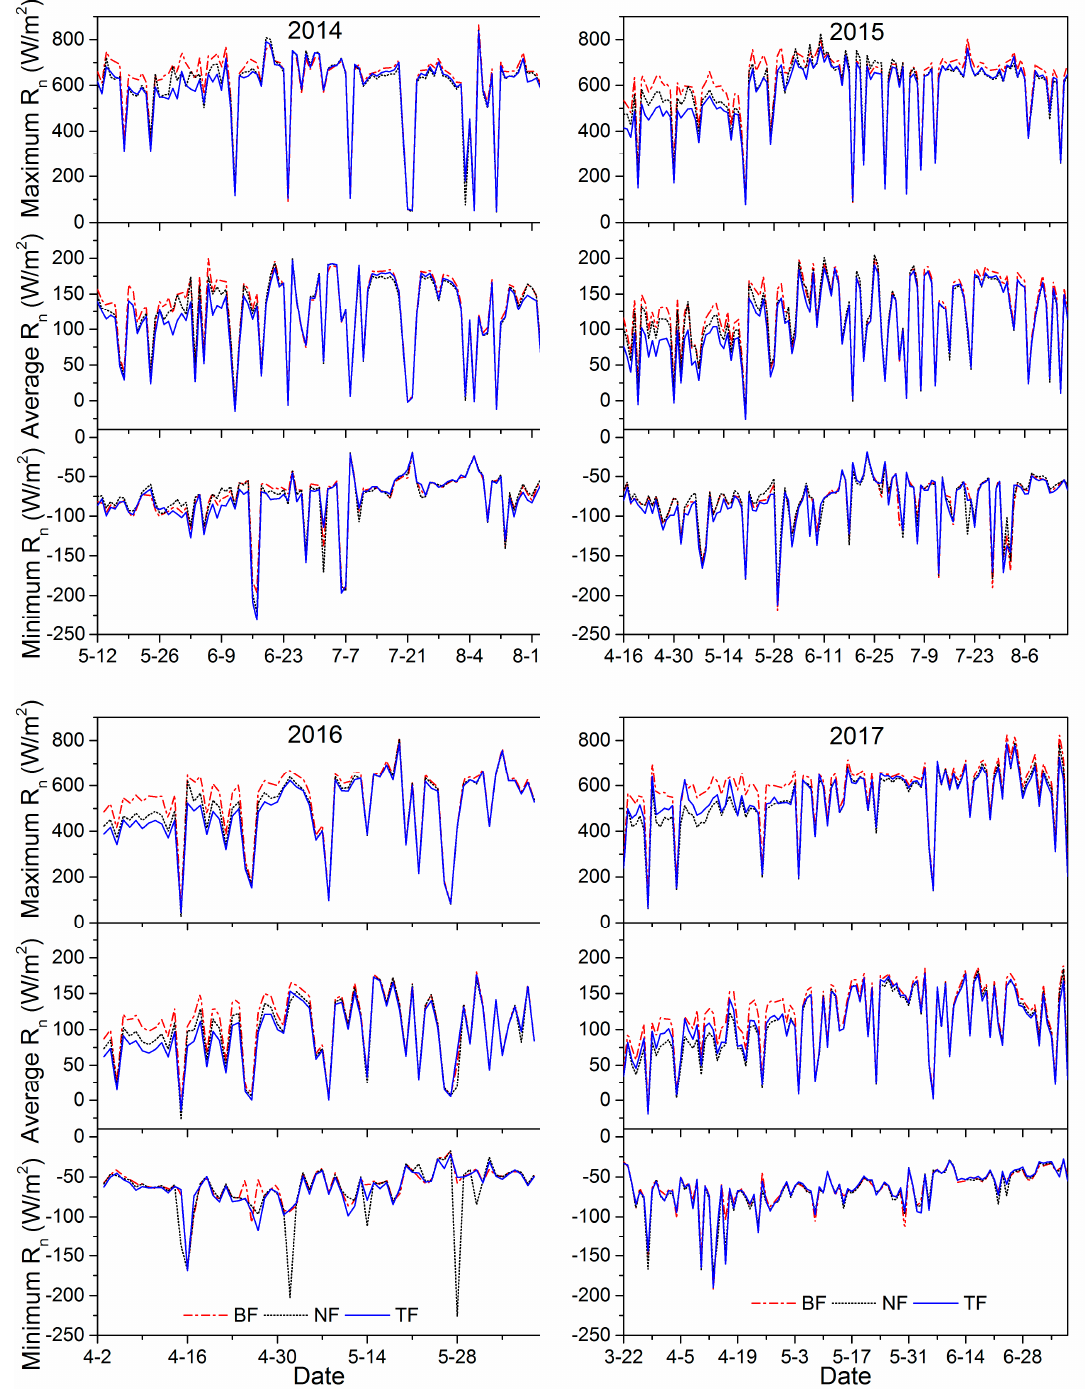
Figure 2. Seasonal variations of the daily maximum net radiation (R n ), daily average net radiation (R n ), and daily minimum net radiation (R n ) for different mulch treatments: black film (BF), no film (NF), and transparent film (TF) in 2014–2017.